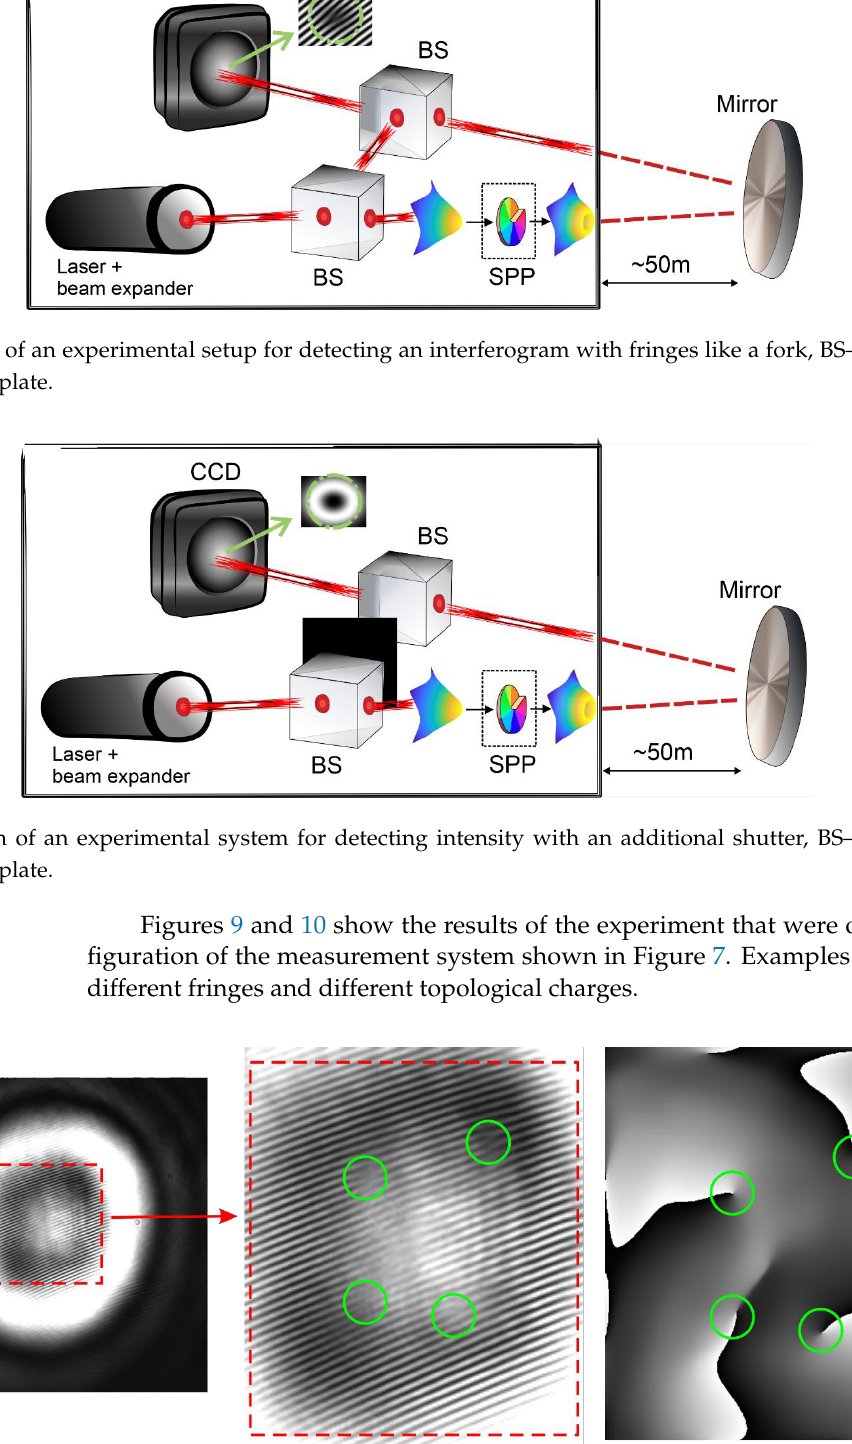
Figure 10. Experimental results with a separated optical vortex with the topological charge of m = 3. The intensity recorded with an additional beam (Figure 7): ( a ) intensity, ( b ) magnified intensity area, ( c ) phase profile. The green circles represent the locations of the vortex points. Locating the vortex points that are at the bifurcation of the fringes requires the fol- lowing steps: notches for fringe field analysis and the application of the optical Fourier transform. Then, from the map of the diffraction spectrum, the first diffraction order should be selected, and the inverse Fourier transform should be applied to the next limited area (without the zero order). In this way, we obtained the complex distribution and, after calculating the angle, we obtained the phase maps shown in Figures 9c and 10c. The jumps in the phase value appear on the obtained phase maps. It is important to find the ends of these lines, and image processing methods locate these ends with an accuracy not exceed- ing 1 pixel; to increase the accuracy of determining points, the authors used neural net- works that analyzed selected regions with dimensions of 20 by 20 pixels, with the end of the phase jump line placed in the center of the cut area [34,35]. The learned artificial neural